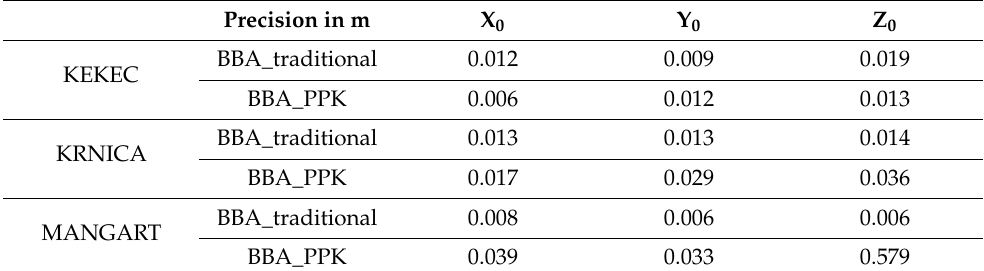
Table 2. Precision of the coordinates X 0 , Y 0 and Z 0 in processing used as the perspective centers for BBA_PPK method and precision values for the GCP in the